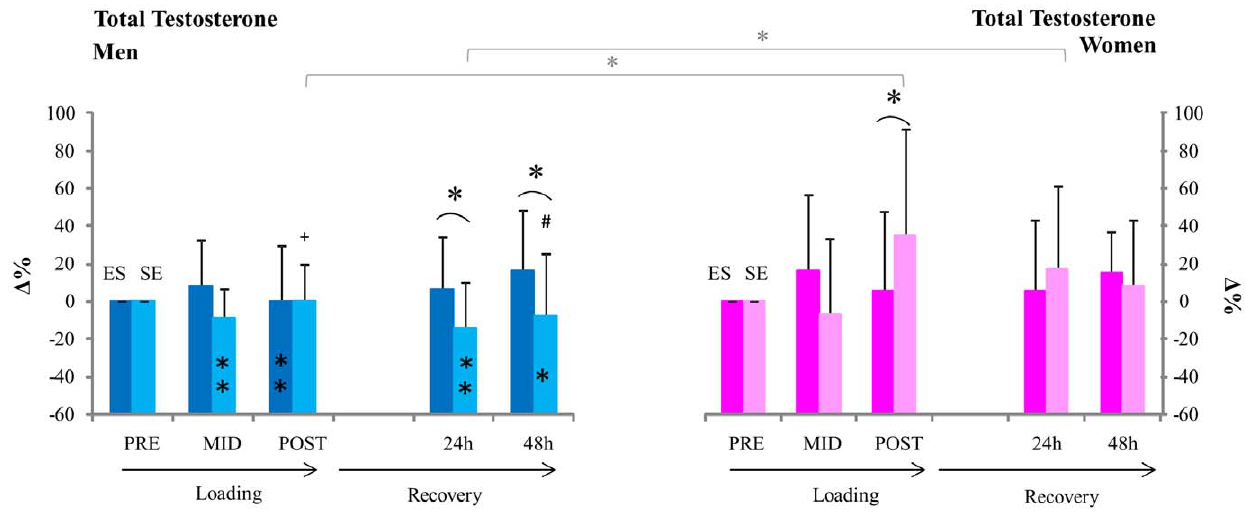
Figure 3. Serum total testosterone. ** inside column=significant change (p , 0.01) from pre in absolute serum total testosterone concentrations, + =significant change (p , 0.05) in absolute serum total testosterone from mid. *[=significant difference (p , 0.05) between relative changes in serum testosterone concentrations from pre in men and women. *(=significant difference (p , 0.05) between relative changes from pre in ES and SE loadings.